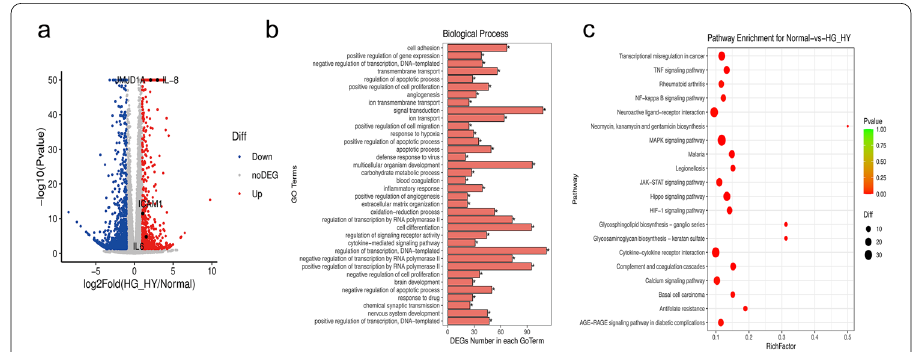
Fig. 5 Gene expression of HUVECs induced by high glucose and hypoxia exposure by RNA-sEq. a Volcano plot was used to show the difference in gene expression values between the control group and the high glucose hypoxia group. Grey dotted line indicates the threshold for p < 0.05 and log FC < 2. Blue and red points represent down-regulated and up-regulated DEGs respectively. GO ( b ) and KEGG enrichment analysis ( c ) of differentially expressed genes (correct p < 0.05). Biological processes are indicated in red, and red bubbles show KEGG